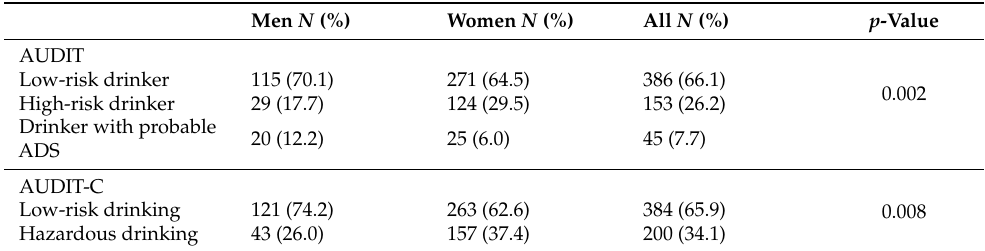
Table 3. Problems with alcohol consumption by sex according to AUDIT.